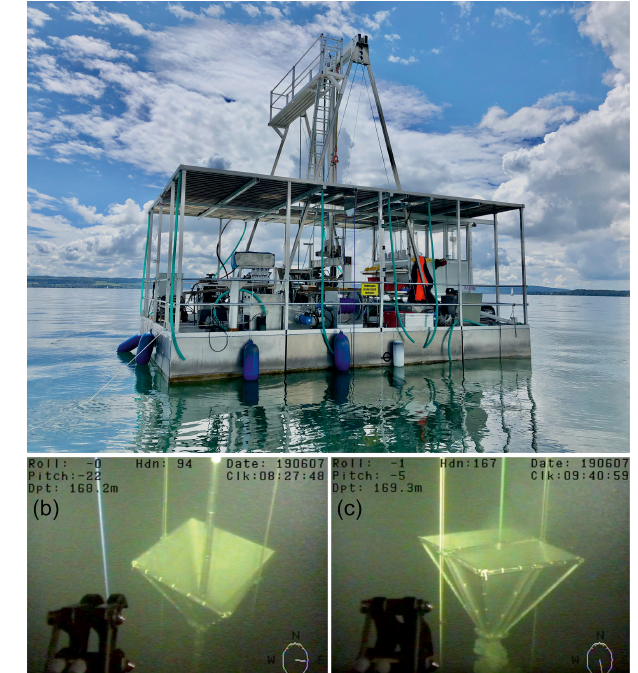
Figure 2. Hipercorig on Lake Constance during coring operations in 2019 (a) . Video stills from research vessel (R/V) Kormoran re- motely operated vehicle (ROV) showing the entry of coring assem- bly in the upper reentry cone (b) . The reentry cone with hydraulic hose (green) after the coring assembly was lowered into the hole (c) .